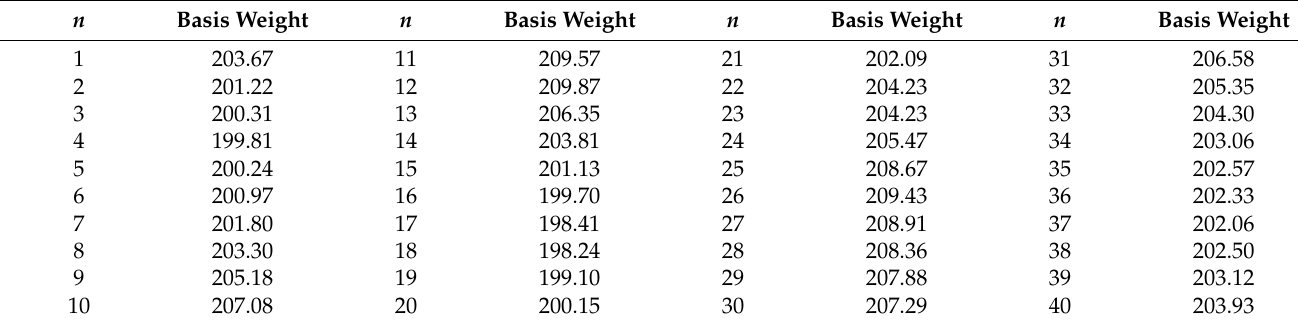
Table 8. Basis weight values (grams) from